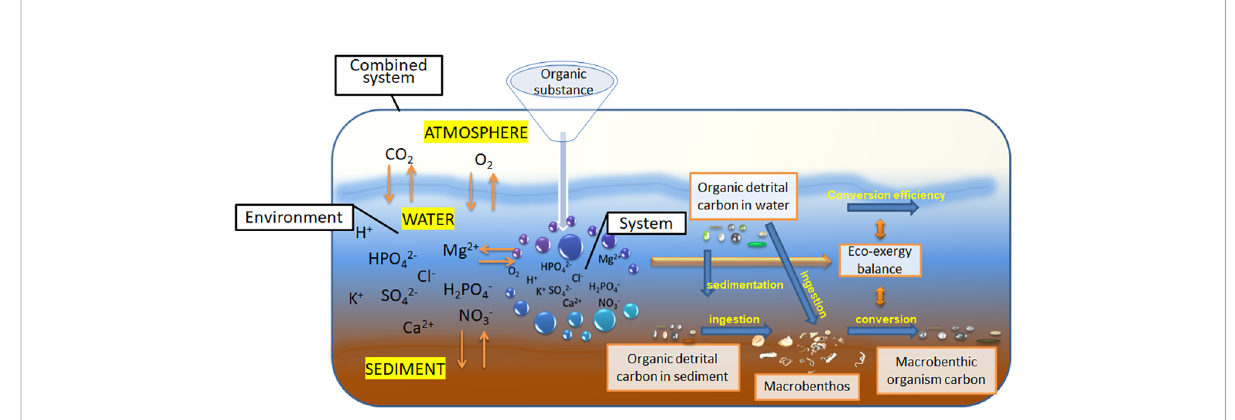
FIGURE 1 The relationship between macrobenthic carbon and organic carbon in sediments under the hypothetical system of thermodynamic